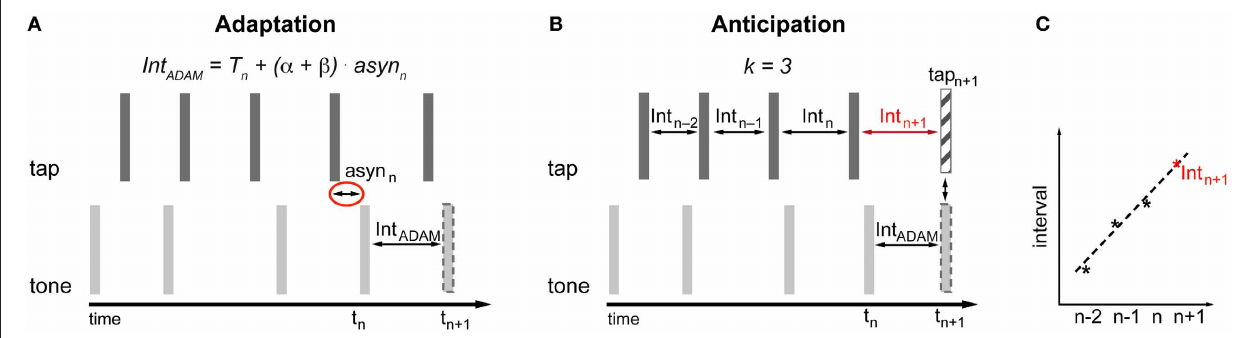
FIGURE 3 | Implementation of adaptation (A) and anticipation (B,C) in ADAM. asyn, asynchrony; Int, interval; T, Timekeeper period. (A) The time of occurrence of the next tone is determined based on the asynchrony and the settings of error correction parameters α and β (Equation 1). The setting of β affects the current timekeeper period (Equation 2). The interval produced by